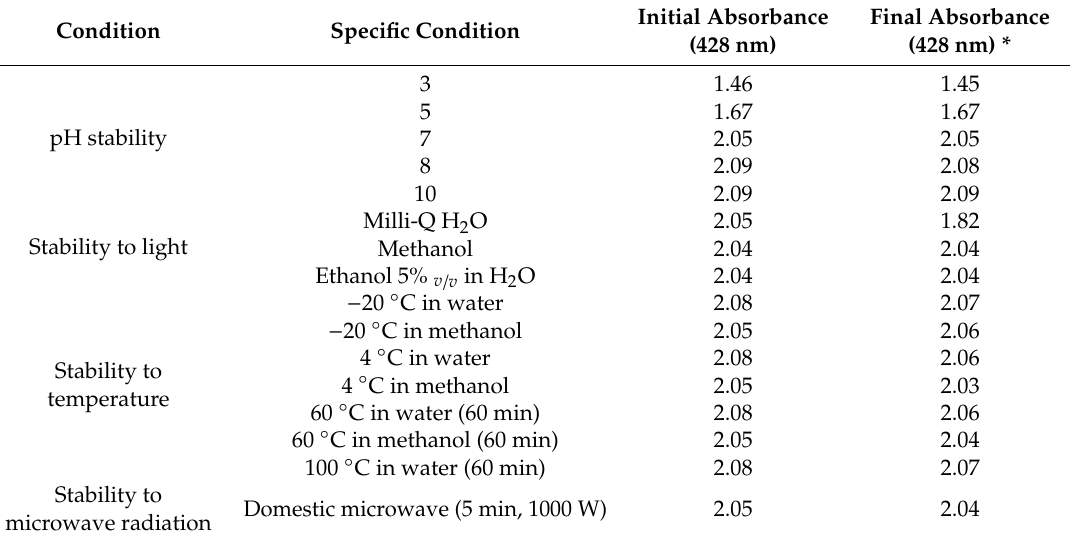
Table 1. Stability of antifungal yellow compound (epipyrone A) in di ff erent conditions. Condition